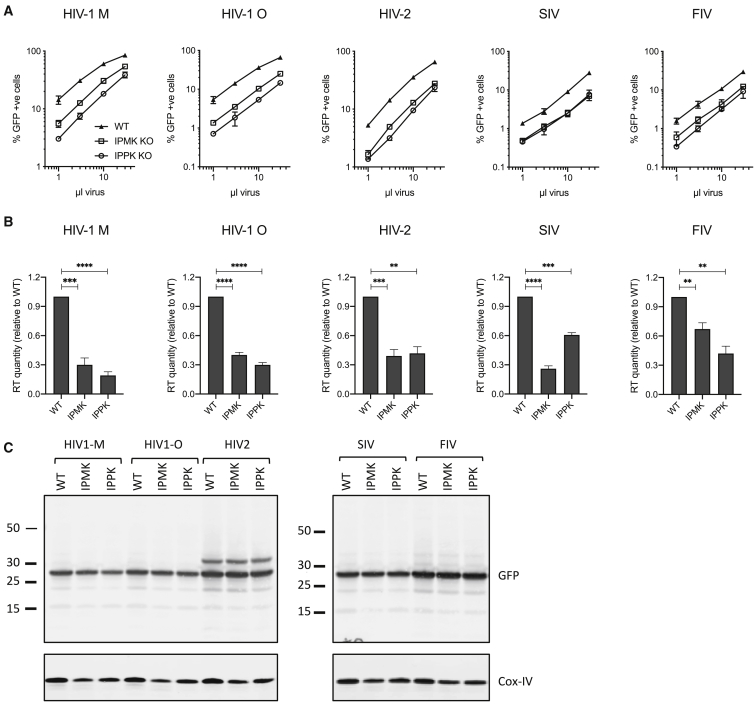
The Requirement for IP6 during Viral Production Is Conserved in Diverse Lentiviruses(A) Titers of viral supernatants for lentiviruses produced in WT, IPMK-KO, and IPPK-KO 293T cells. Titers are determined by percentage GFP infection on WT 293T cells.(B) Quantification of viral production as determined by RT levels in viral supernatants. Values shown are mean ± SD from three independent experiments. Statistically fewer virions are produced in kinase-knockout cells (p < 0.002 in all cases).(C) Western blots for GFP expression during viral production show similar protein levels for each cell line. Bottom panel shows loading control Cox-IV.